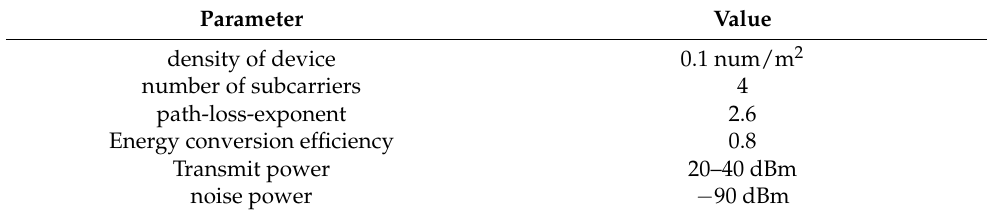
Table 2. Simulation experiment parameters.